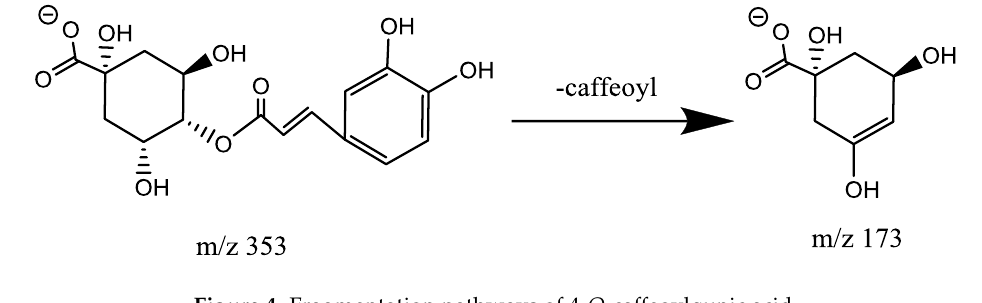
Figure 4. Fragmentation pathways of 4- O -caffeoylqunic acid.